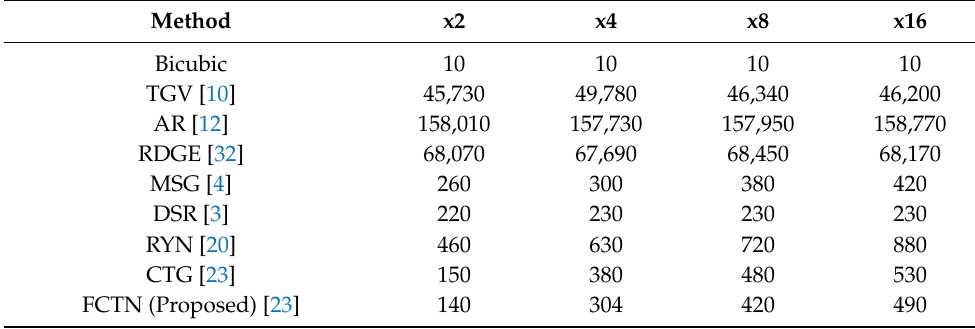
Table 5. Average inference times (milliseconds) for different scaling factors.